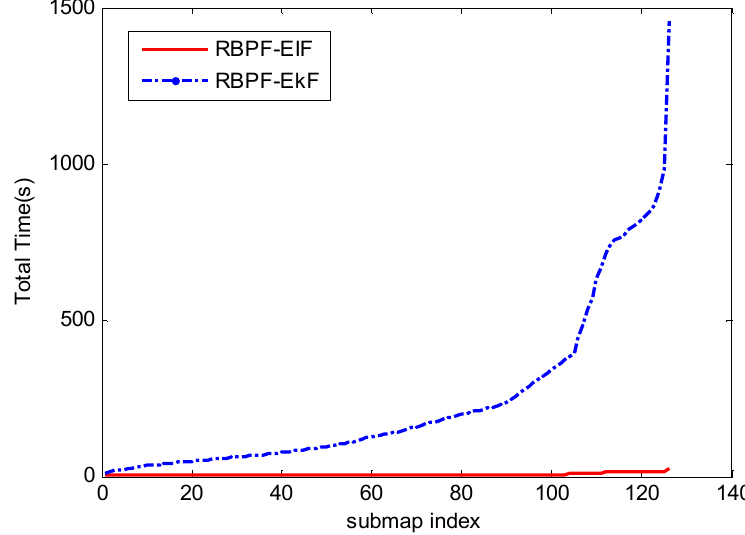
Figure 8. The computational time used for submap joining by RBPF-EKF and